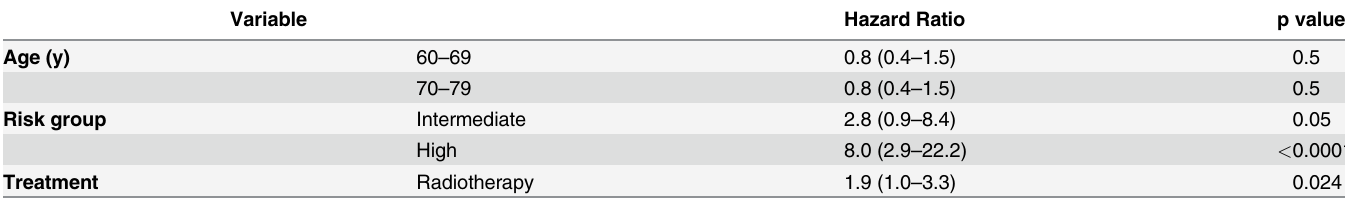
Table 4. Multivariate analysis of variables predictive of cancer speci fi c mortality from radical therapy.